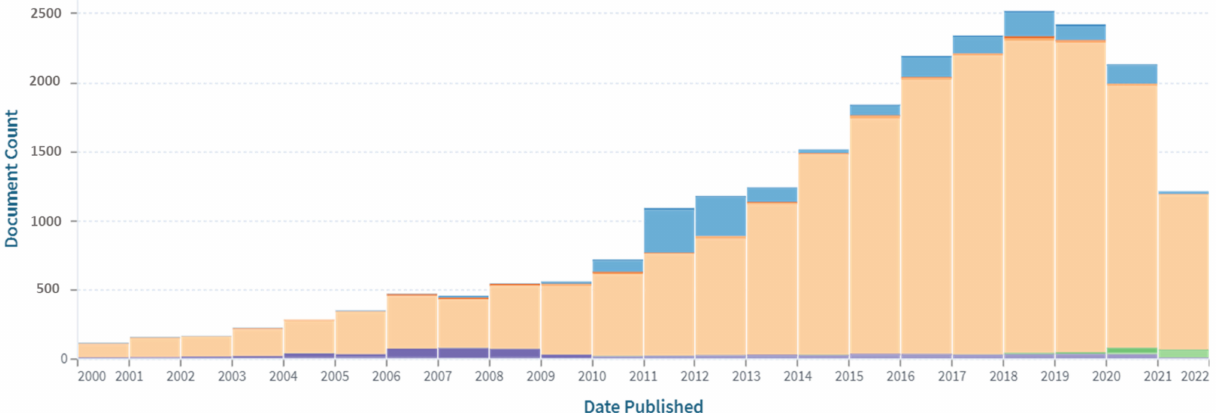
Figure 1. The annual number of scholarly works on SACs. (The Lens scholar analysis search system (formerly Patent Lens): search term “single-atom-catalyst” within 2000–2021. https://link.lens.org/UXZ0NOGgH3i (accessed on 11 October